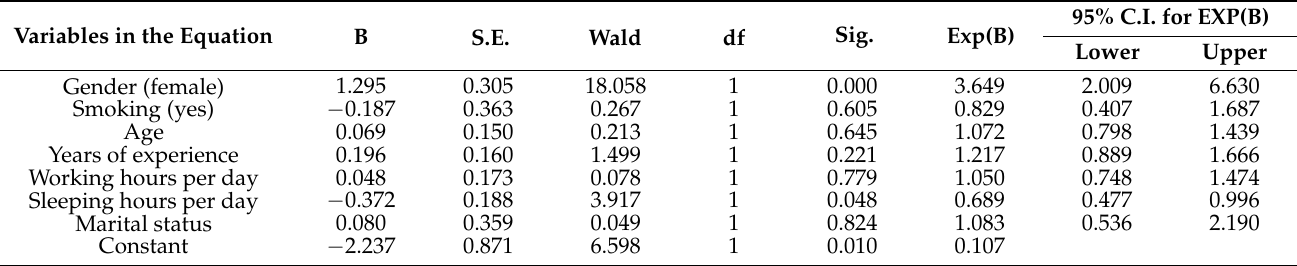
Table 6. Binomial regression results for knee disorder with different study